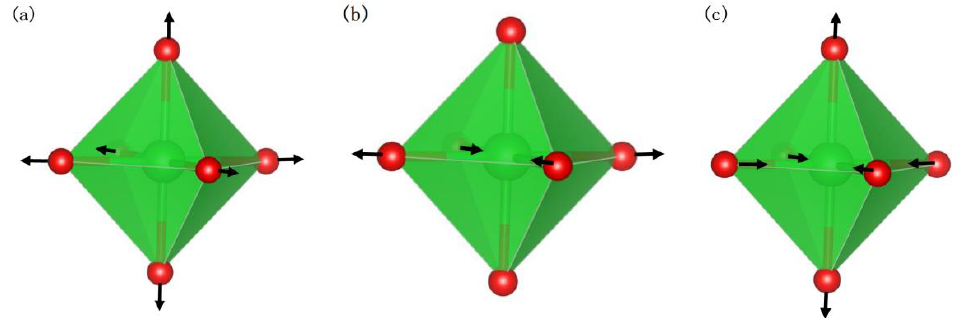
Figure 8. Three kinds of distortion models for the Mn-O bond ( a ) The surface tension contract model Q 1 ; ( b ) The plane distortion model Q 2 ; ( c ) The expansion mode, or inspiratory mode Q 3 .